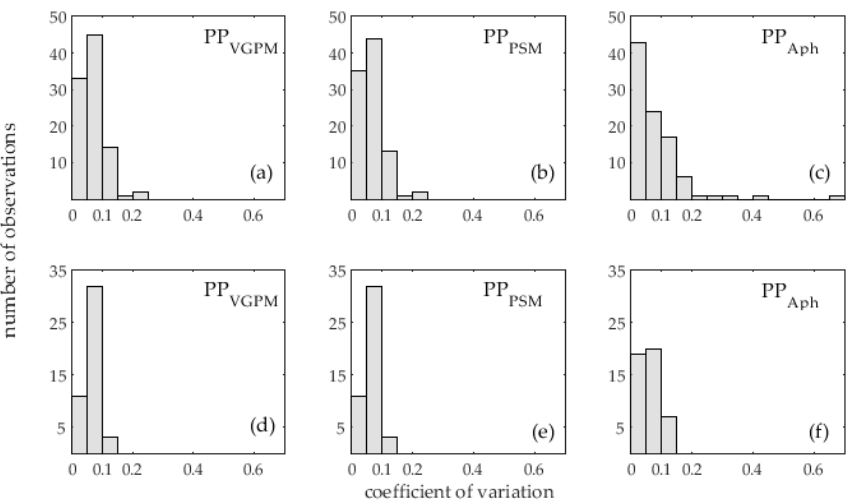
Figure 10. Histograms of the coefficient of variation of satellite PP eu for the area of 12 × 12 km (3 × 3 pixels) for each match-up station analysed using eight day composite data ( N = 95) for ( a ) PP VGPM ; ( b ) PP PSM ; and ( c ) PP Aph and using daily data ( N = 46) with ( d ) PP VGPM ; ( e ) PP PSM ; and ( f ) PP Aph .